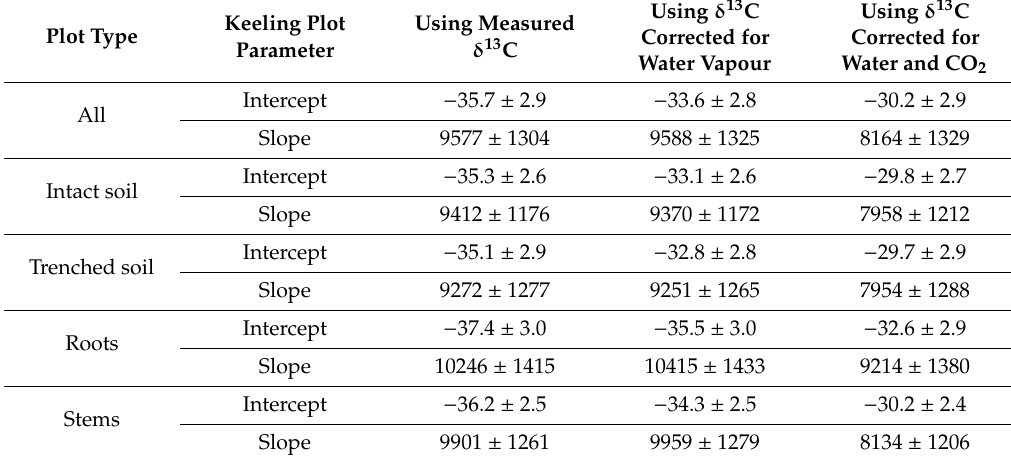
Table 1. The mean Keeling plot intercepts (the determined δ 13 C of the CO 2 flux) and slopes using the measured δ 13 C, the δ 13 C corrected for water vapour and the δ 13 C corrected for both water vapour and CO 2 concentration dependence, respectively. The means are shown for all measurements together and individually for intact soil, trenched soil, roots and stems, respectively. All δ 13 C values were calibrated against a standard calibration gas with known δ 13